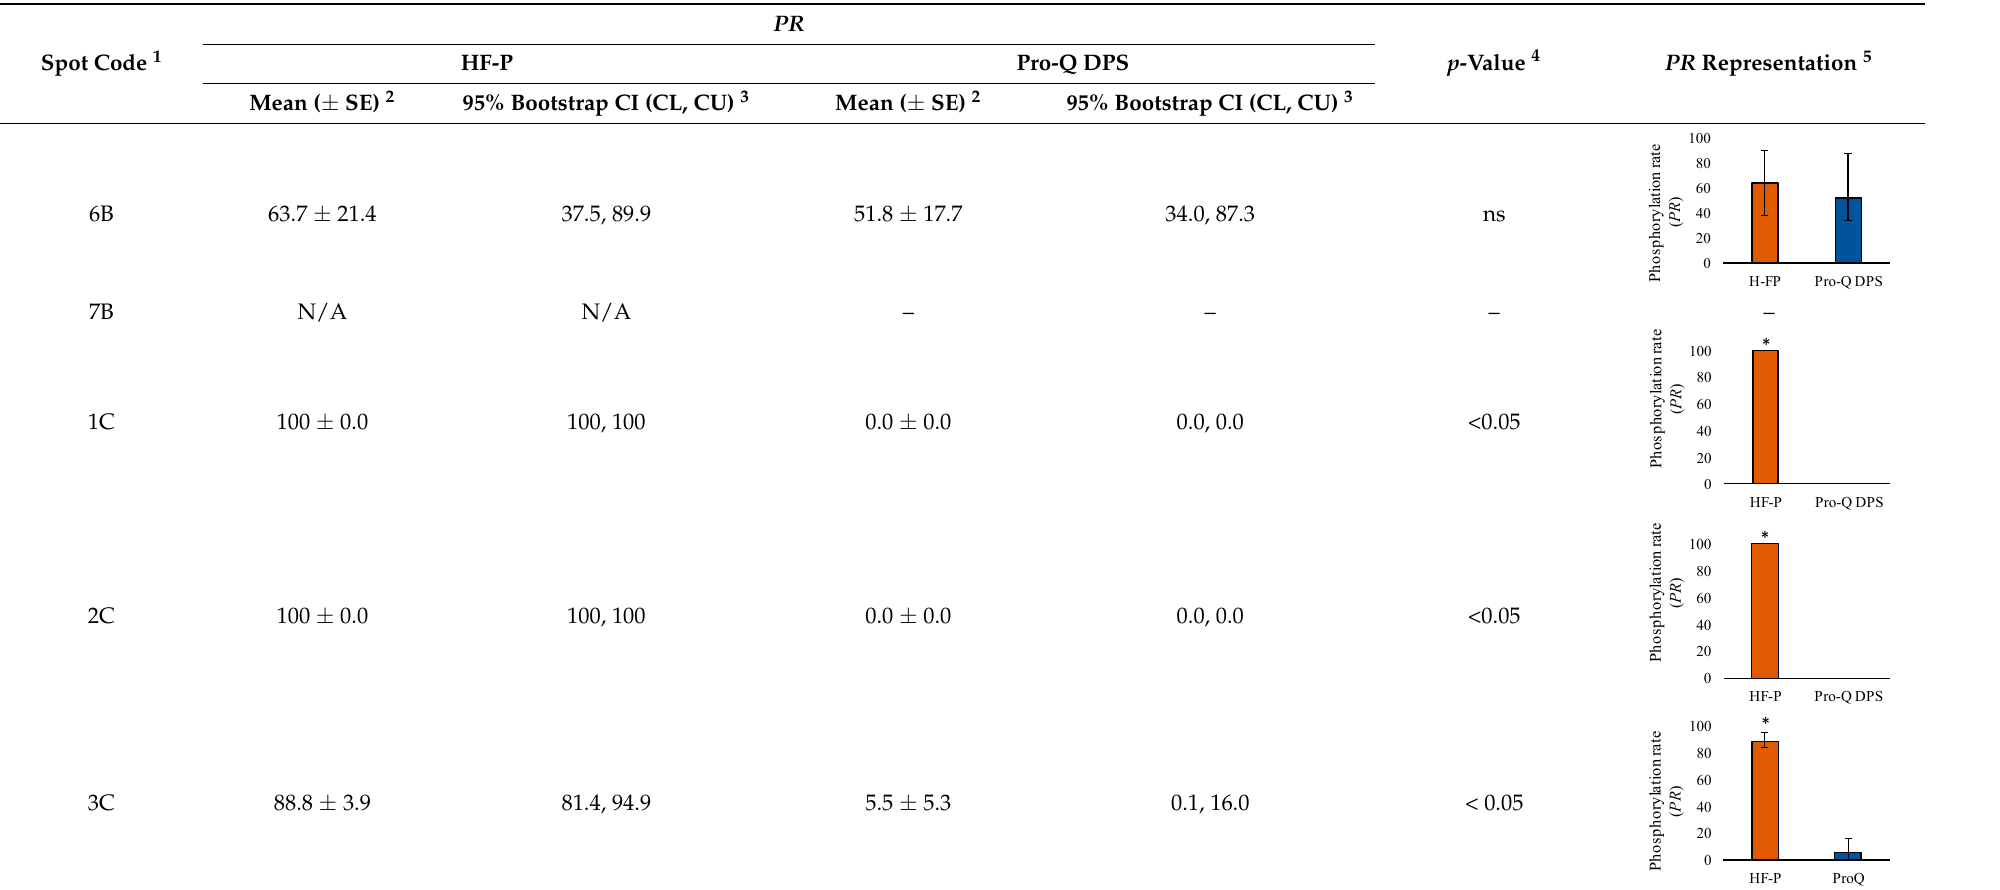
1 Gel position of numbered spots is shown in Figure 3.; 2 Data are means of PR ± standard error from three biological replicates.; 3 CI, confidence interval; CL, lower bound; CU, upper bound. The 95% bootstrap CIs were acquired by the bias-corrected percentile method and corrected by the Bonferroni method.; 4 p -value < 0.05: statistically significant difference in mean PR between methods; ns: no statistically significant difference ( p > 0.05); 5 Asterisk indicates a significant difference ( p - value < 0.05) in mean PR between methods.; N/A = not applicable, spot with more volume in treated samples than untreated with HF-P.